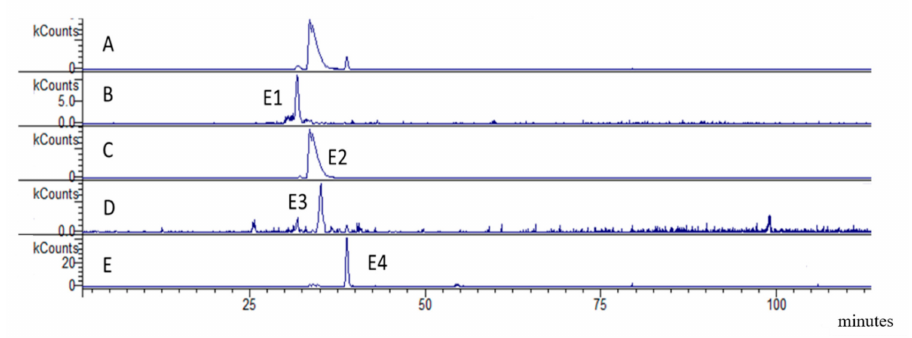
Figure 4. B. retusa bark, LC-MS chromatogram peaks, identified compounds are indicated as in Table 2. ( A ). total ion current of chromatogram; ( B ). epigallocatechin sulphate:E1; ( C ), Epicatechin-7- O -sulphate: E2; ( D ), Epigallocatechin: E3; ( E ), Epicatechin: E4.